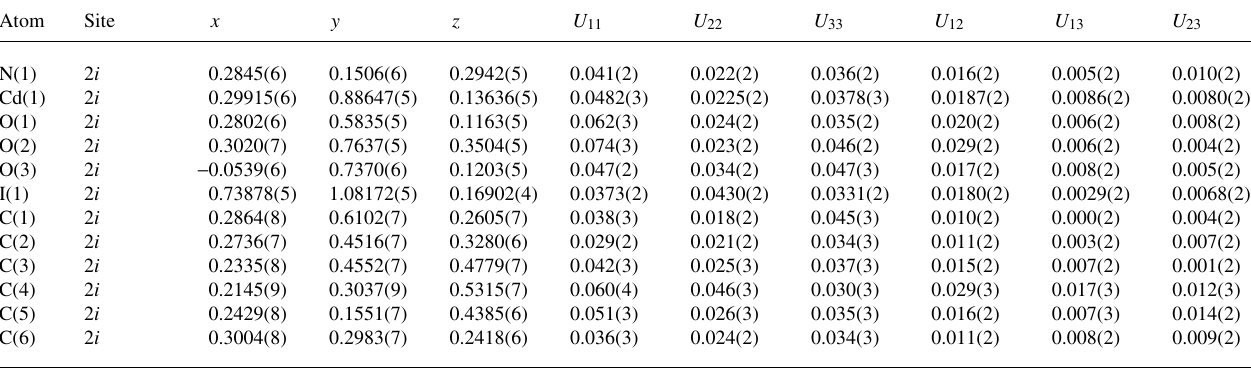
Table 3. Atomic coordinates and displacement parameters (in Å 2 )